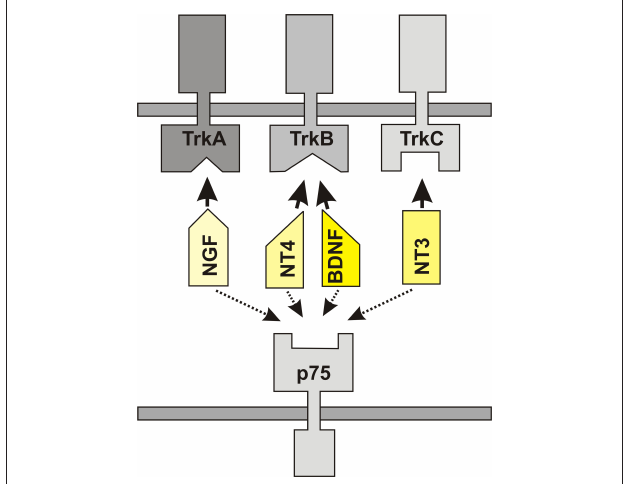
Figure 2 | The family of neurotrophins consists of nerve growth factor (NgF), brain-derived neurotrophic factor (BDNF), neurotrophin 3 (NT3), and neurotrophin 4 (NT4). NGF specifically binds to trkA receptors, BDNF and NT4 specifically bind to trkB and NT3 primarily activates trkC receptors. All these neurotrophins also bind and signal through the low-affinity receptor